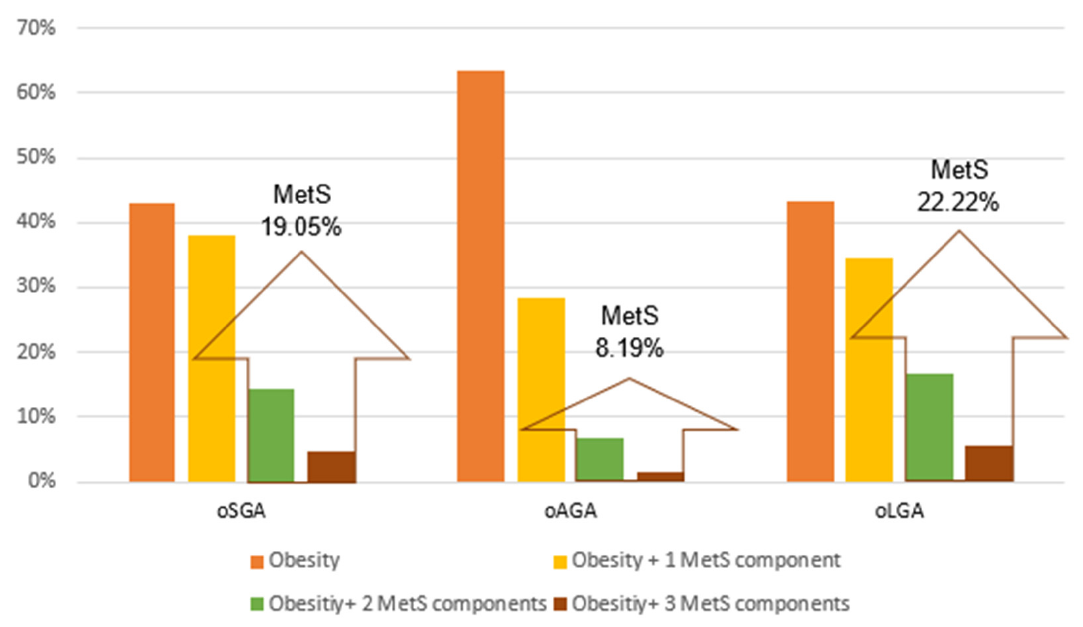
Figure 5. The percentage distribution of metabolic syndrome (MetS) and components among the study